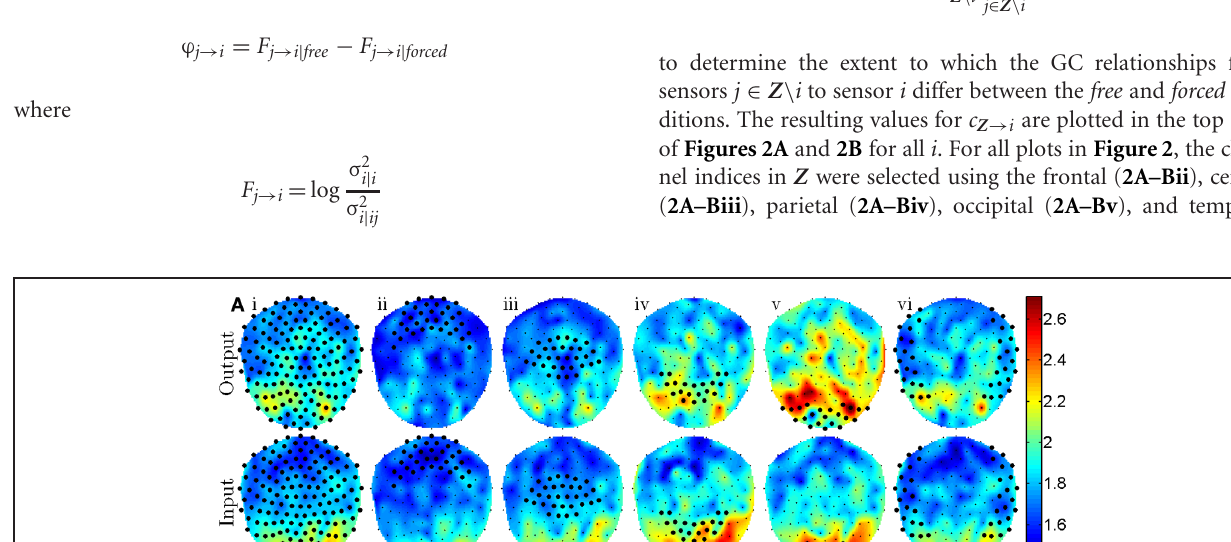
denoted withlarge markers. Bottomrowsof (A and B) indicate regions ofmajor difference in free and forced GC features that have inputs to sensors denoted with large markers. Romannumerals i–vi denote sensor groupings that include all, frontal, central, parietal, occipital, and temporal sensors with a post-hoc addition of grouping vii that includes a portion of left temporal